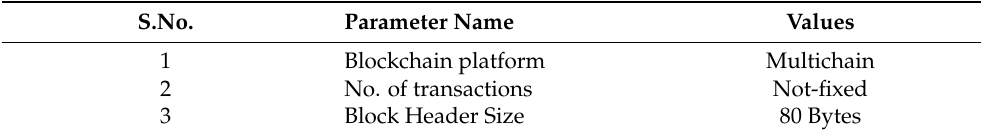
Table 4. Blockchain